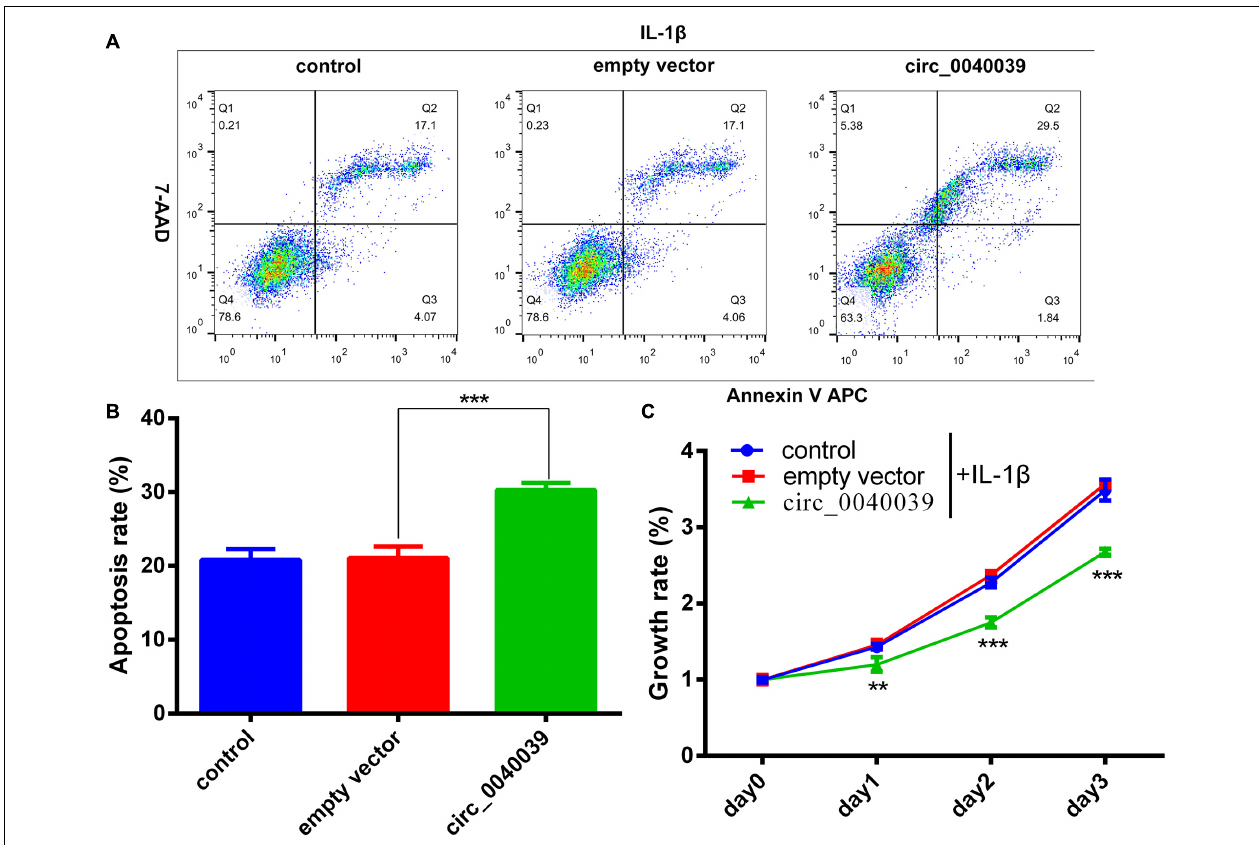
FIGURE 6 | Circ_0040039 promoted NPC degeneration. (A,B) Circ_0040039 overexpression vector or empty vector was transfected into NPCs, and then 20 ng/mL IL-1 β was added to each group to treat NPCs. (A) NPC apoptosis was evaluated using the flow cytometry detection assay. (B) Quantitative analysis of the NPC apoptosis rate. (C) CCK8 assay was used to detect the growth rate of NPCs. ** P < 0.01, *** P <